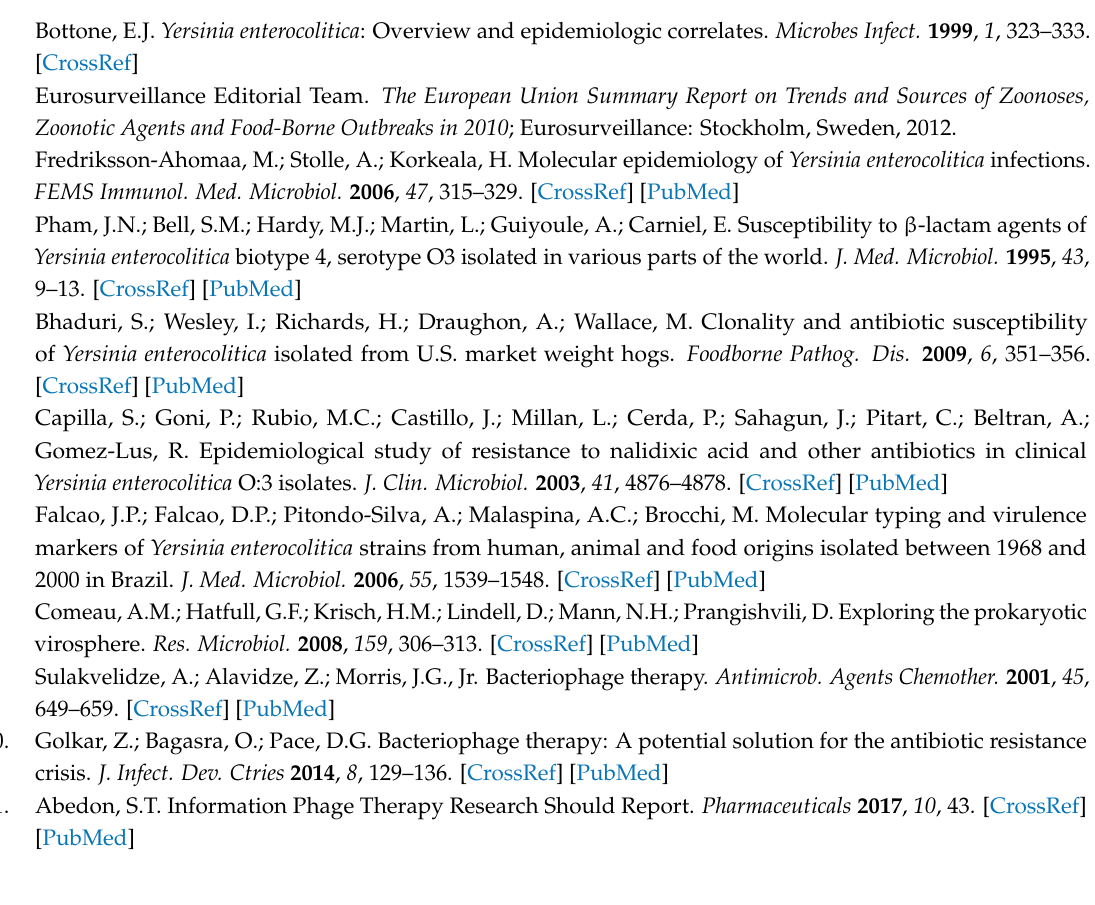
Figure S1: Overview of the multiple alignment of the fPS-phage genomes, Figure S2: Multiple alignments of the phage tail fiber amino acid sequences, Figure S3: Multiple alignment of genomic nucleotide sequences of the fPS-phages, Figure S4: One-step growth curves of phages fPS-9 and fPS-59, Figure S5: Thermal stability of phages fPS-9, fPS-59 and fPS-89, Figure S6: The effect of pH on the stability of phages fPS-9, fPS-59 and fPS-89, Table S1: Comparison of the fPS-phage gene products to those of fPS-7, Table S2: Whole genome DNA sequence comparisons of fPS-phages using the EMBOSS stretcher program, Tables S3–S18: Predicted promoters and terminators, Table S19: Repeats in the fPS-phage genomes between left TR and phage promoter P1, Table S20: Repeats in the fPS-phage genomes between right TR and phage promoter